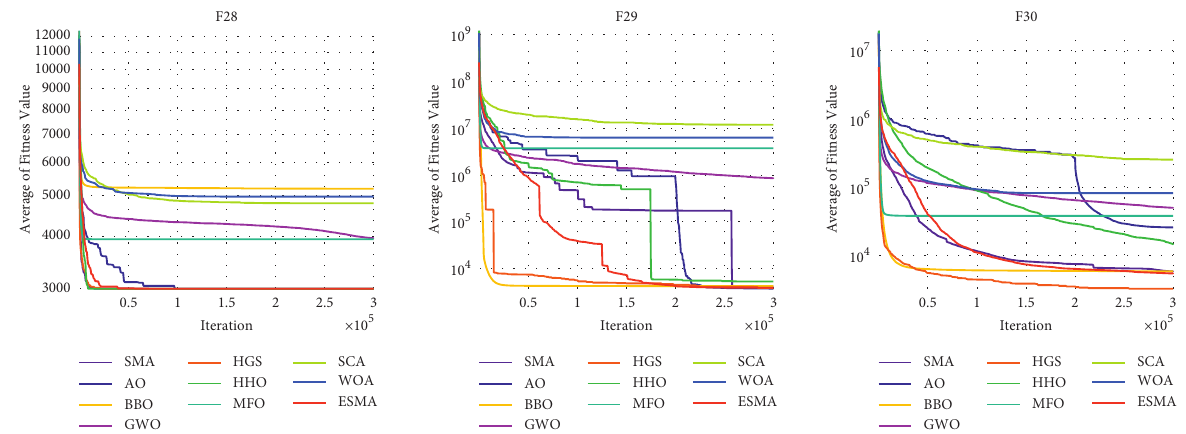
Figure 3: Convergence curves of ESMA and competitors on 30 benchmark functions.